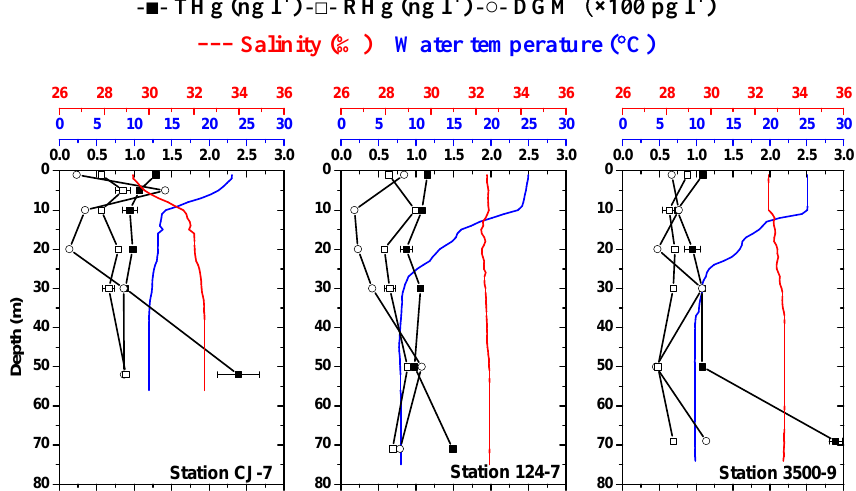
Fig. 6. Vertical distribution of total Hg (THg), reactive Hg (RHg), dissolved gaseous mercury (DGM, largely Hg(0)), water temperature and Figure 6. Vertical distribution of total Hg (THg), reactive Hg (RHg), dissolved salinity in the water column at three stations (Station CJ–7: 32.50 ◦ N, 124.99 ◦ E; Station 124–7: 36.00 ◦ N, 124.00 ◦ E and Station 3500–9: 35.00 ◦ N, 123.50 ◦ gaseous mercury (DGM, largely Hg(0)), water temperature and salinity in the water column at three stations (Station CJ–7: 32.50° N, 124.99° E; Station 124–7: 36.00° N, 124.00° E and Station 3500–9: 35.00° N, 123.50° E).